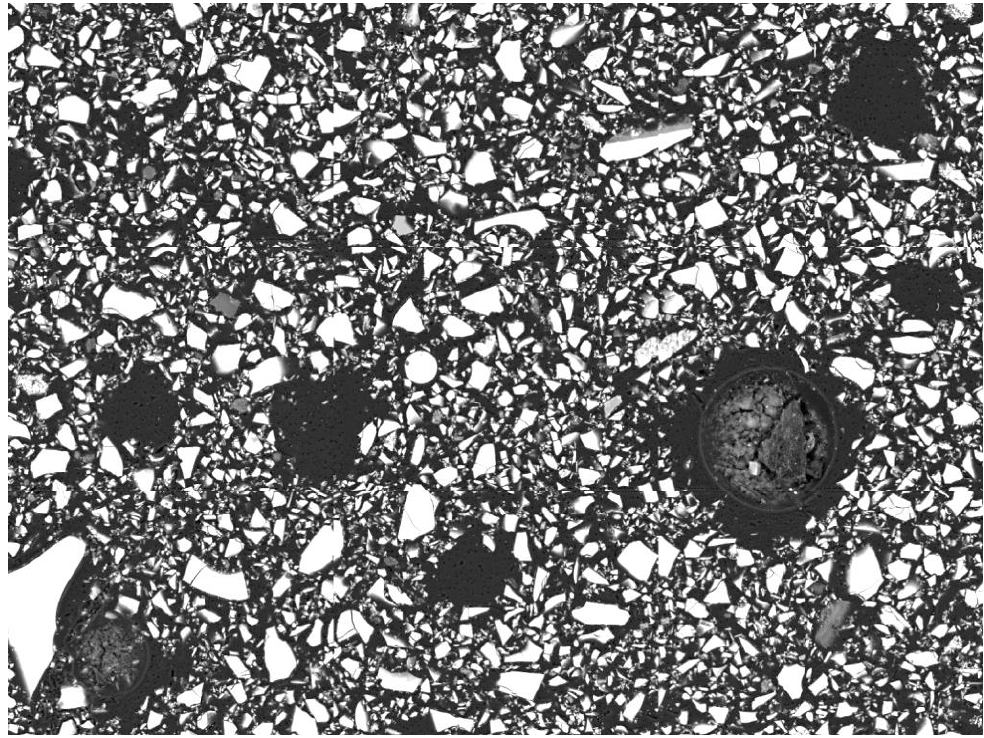
Figure 7. Large area BSE image of a polished section of an epoxy-impregnated unreacted GBFS (the number of acquired fields was 9). The image width is 768 μm.